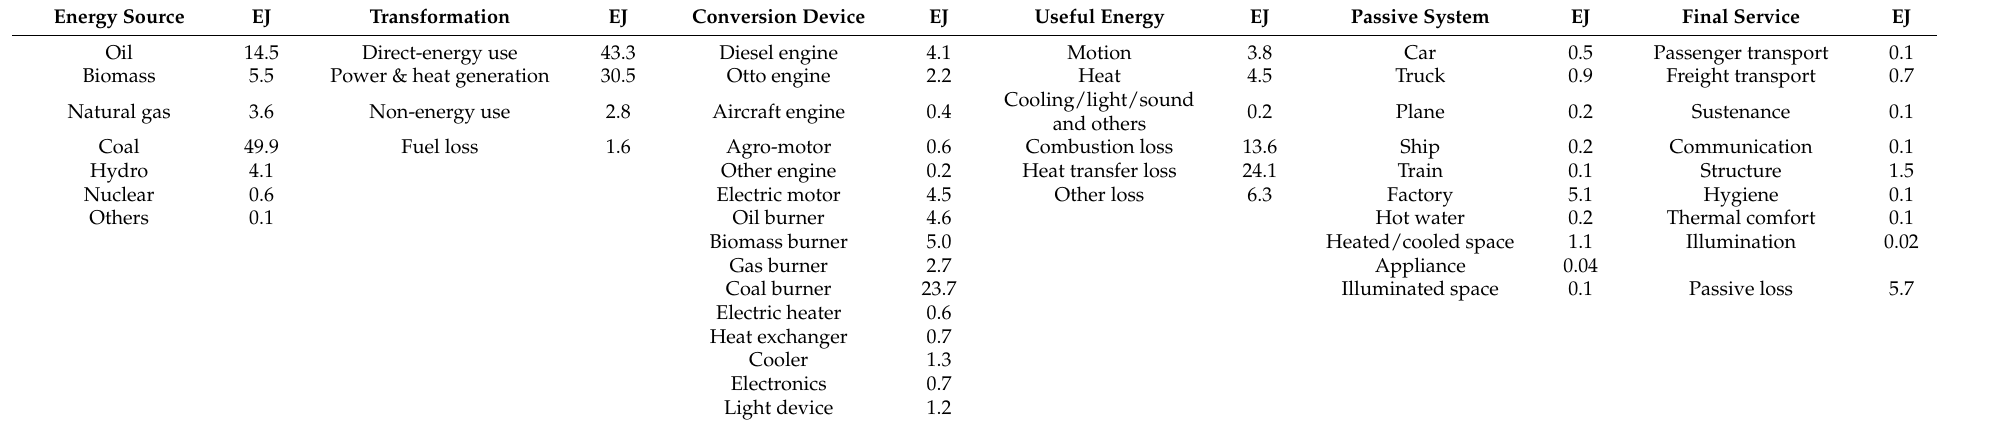
Table A1. Vertical slices of exergy flow of China in 2005.